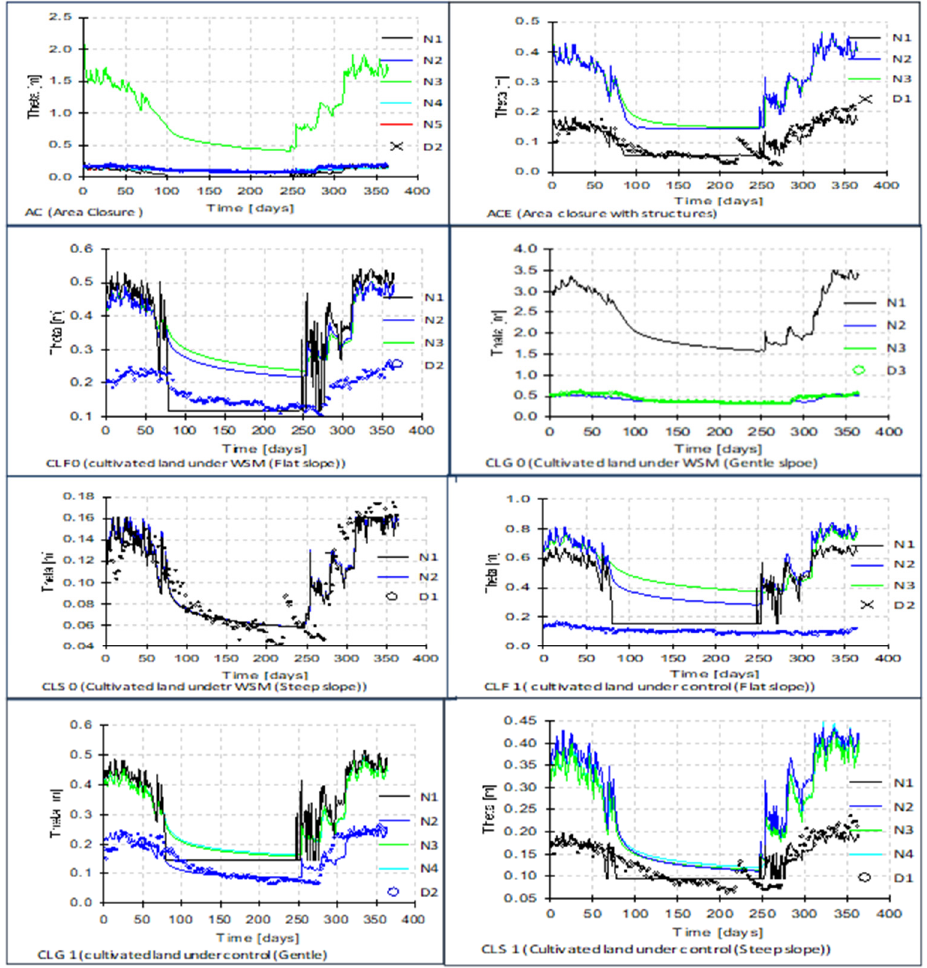
Figure 2. Simulated versus measured soil moisture (SM) data of all sites. The simulated SM (theta) in the above output graphs of Hydrus 1D, plotted for each single node or soil layer (N), was given as the no. of Ns represented by a unique color in the plots. Each observation node N represents the soil layers within each 400 mm